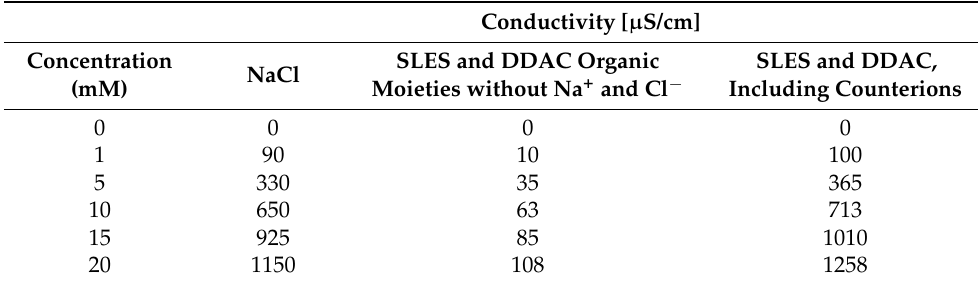
Table 2. Conductivity values of NaCl, the organic moieties of SLES and DDAC without contribution of Na + and Cl − , and the two surfactants including the